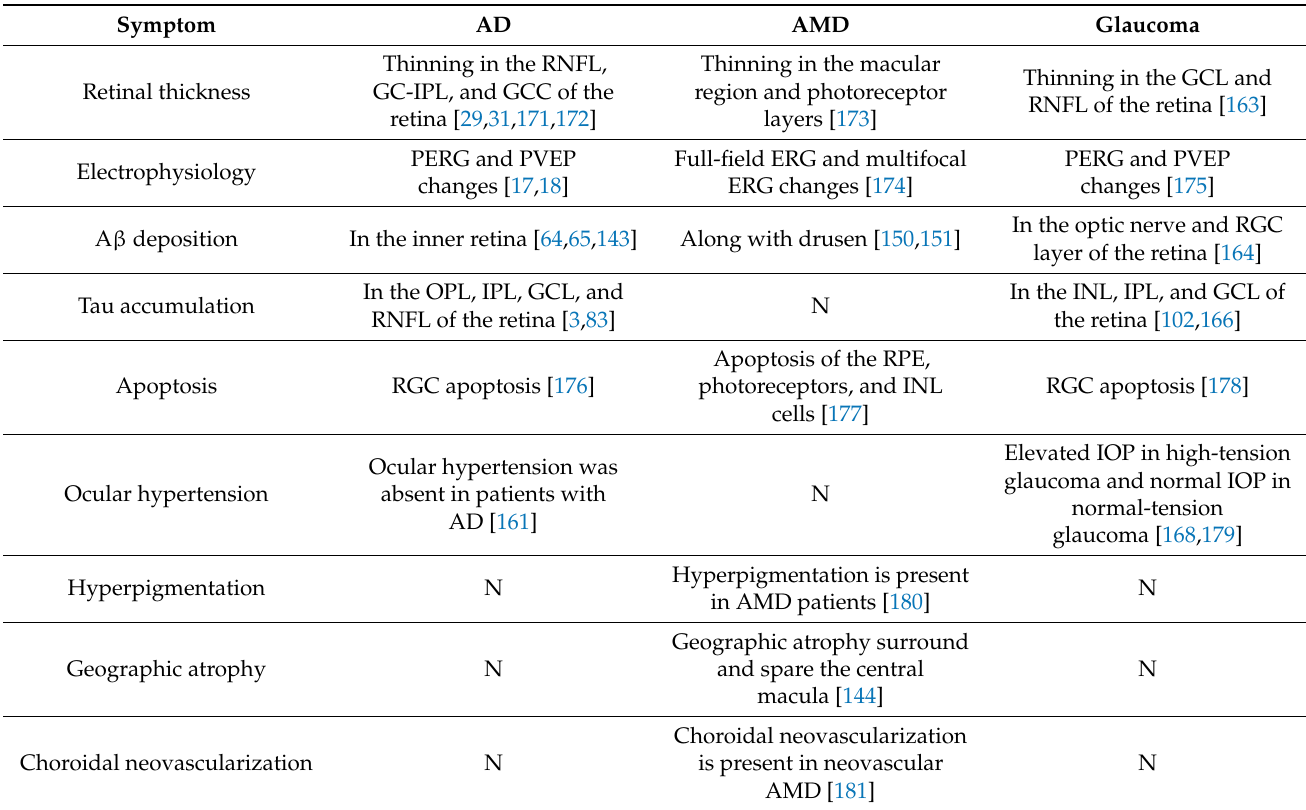
Table 2. Comparison of retinal changes in Alzheimer’s disease, age-related macular degeneration, and glaucoma. Symptom Retinal